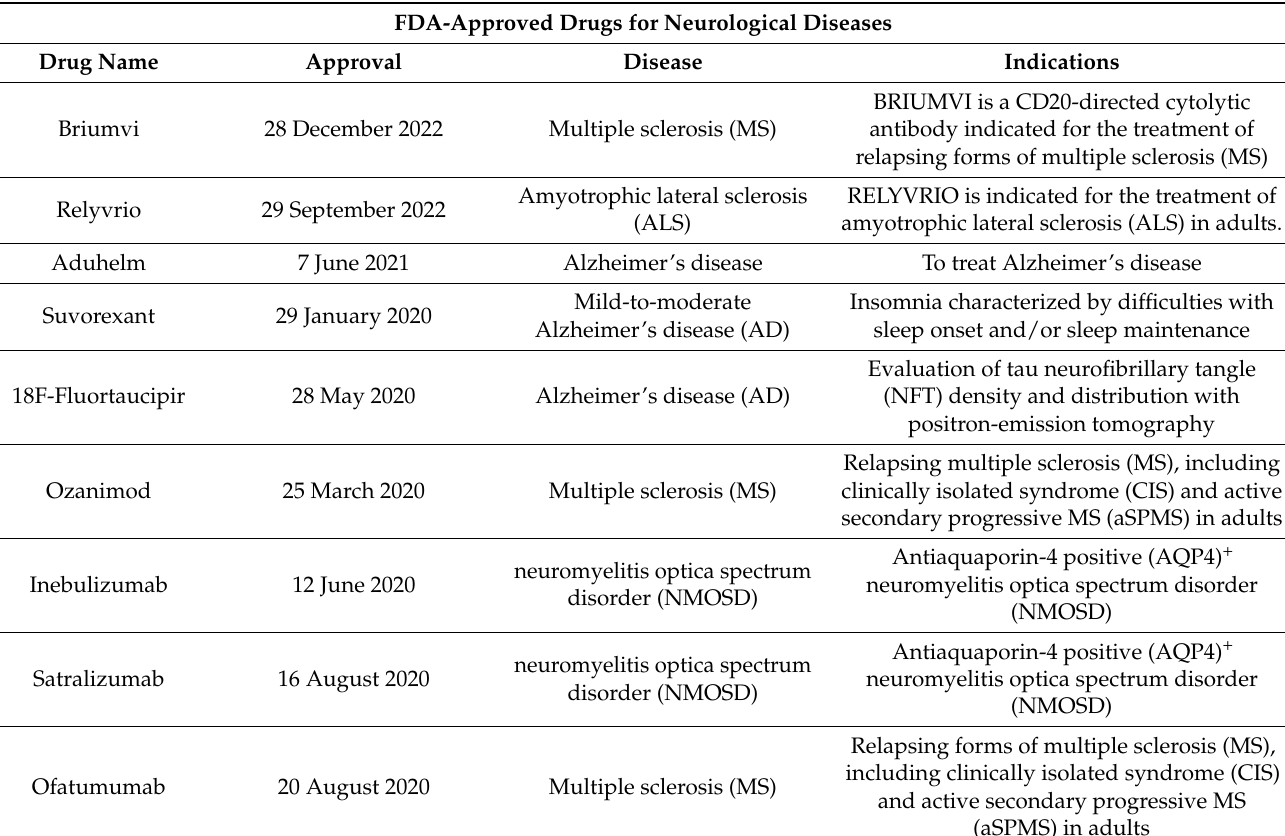
Table 1. FDA approved drugs for neurological